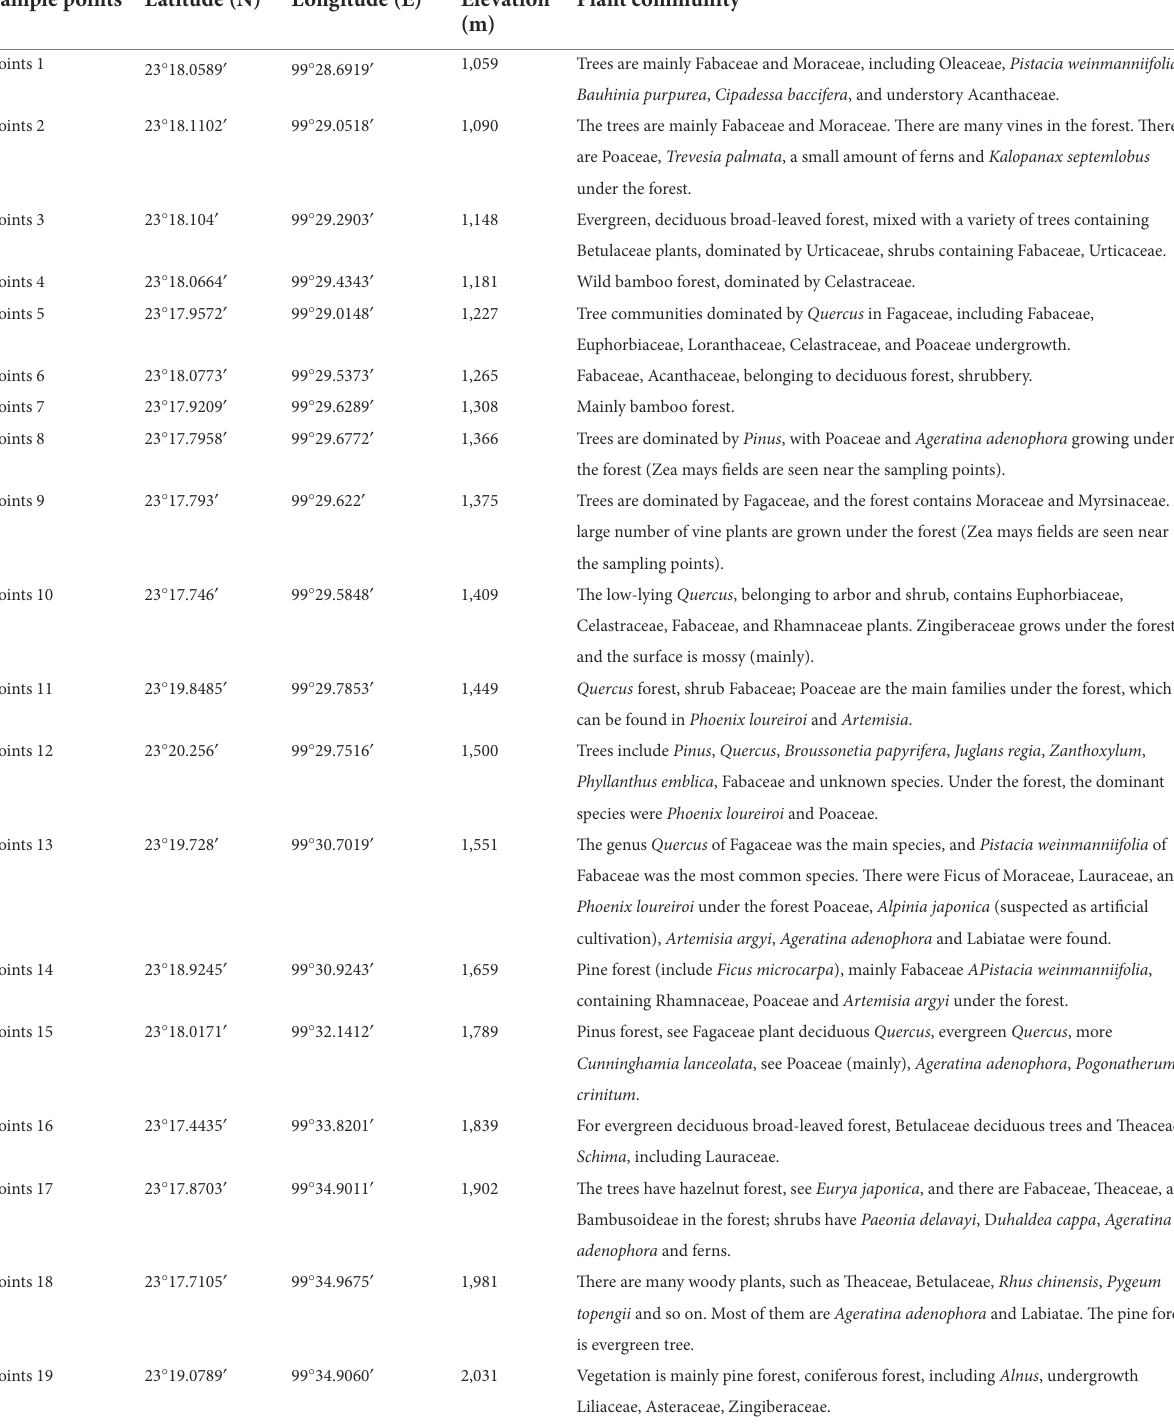
TABLE 2 Original records of surface soil sample collection near Nongke Village, Meng Province Town, Cangyuan County. Sample points Latitude (N) Longitude (E) Elevation